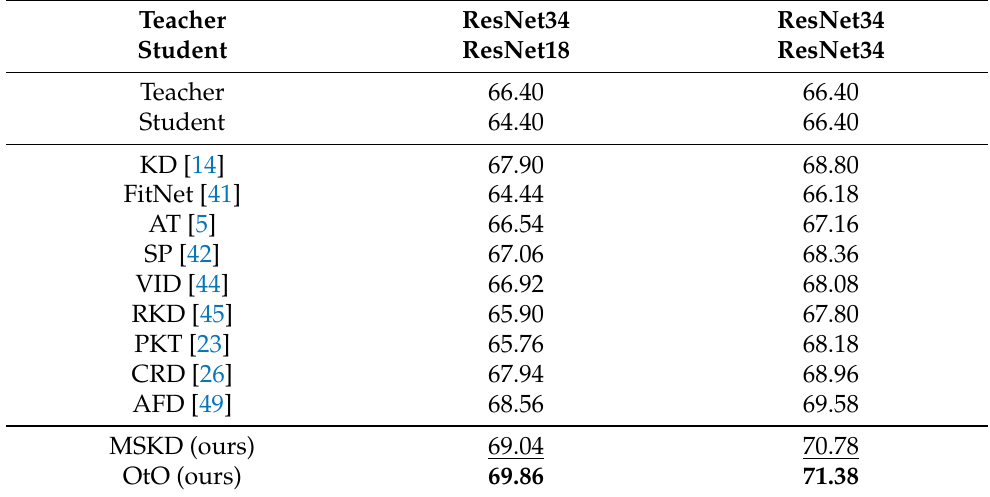
Table 5. Comparison of accuracy (%) of the proposed method with those of other KD methods for Tiny ImageNet. The best and second-best results are shown in bold and underlined,